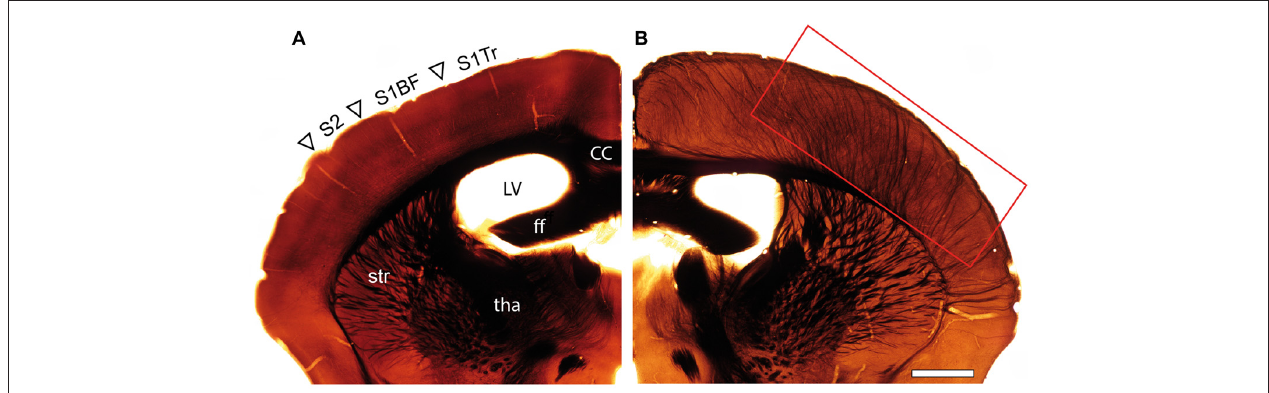
FIGURE 1 | Organization of fiber tracts in the adult wild type (WT) and reeler mouse. (A,B) Comparison of an adult WT (A) and reeler (B) mouse coronal hemisphere after osmium-treatment and embedding for EM. Note the massive fiber bundles (framed area) in somatosensory and motor areas in the reeler mouse neocortex. Abbreviations in (A) : cc, corpus callosum; ff, fimbria fornix; LV, lateral ventricle; tha, thalamus; str, striatum; S1Tr, primary somatosensory cortex trunk region; S1BF, primary somatosensory cortex “barrel field”; S2, secondary somatosensory cortex. Scale bar 1